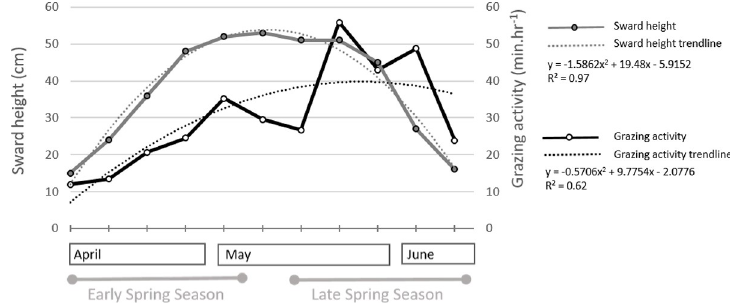
Fig 5. Values and trendlines of sward height (cm) and grazing activity (min.hr − 1 ).